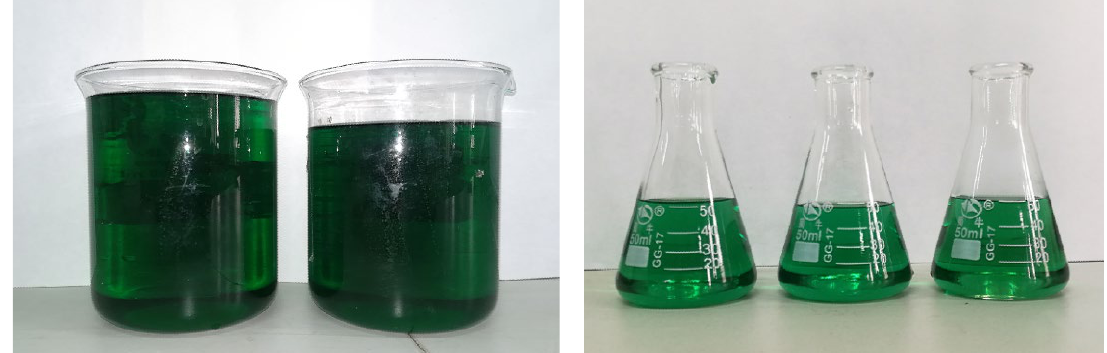
Figure 2. Pressurized leaching solutions. Table 1. Main phases of waste NMC-8111 ternary lithium battery.